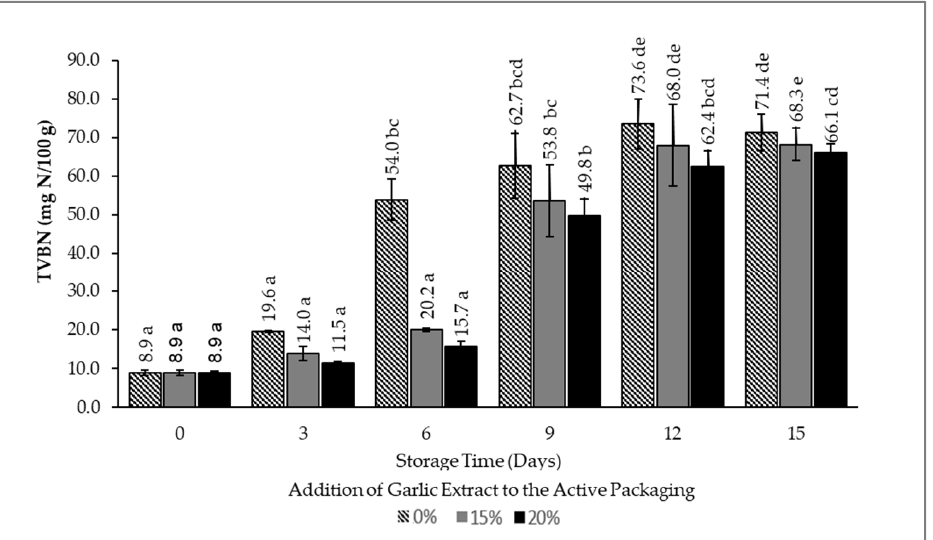
Figure 5. TVBN value of beef packaged using intelligent and active packaging with the addition of garlic extract. The mean value followed by various letters indicates a significant difference ( p <